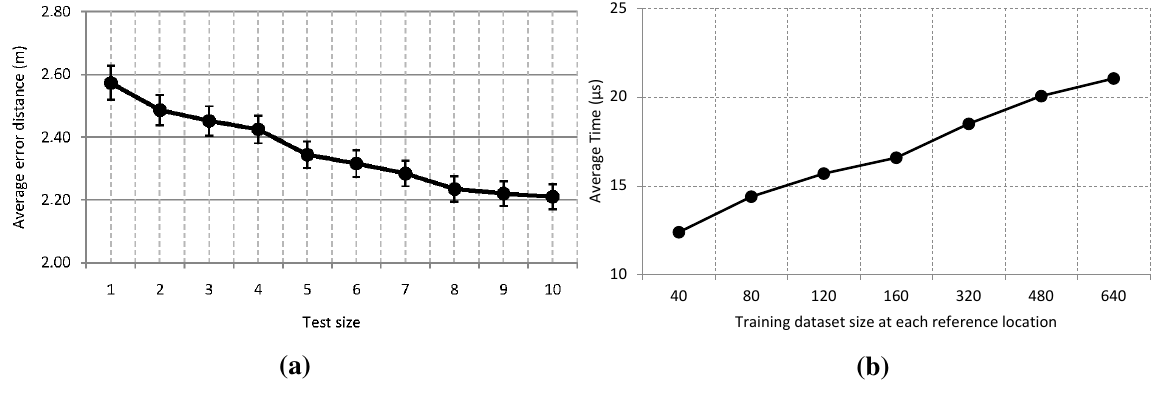
Figure 6. ( a ) Effect of the test size on the performance of the system; ( b ) effect of the training size on the elapsed time to estimate a